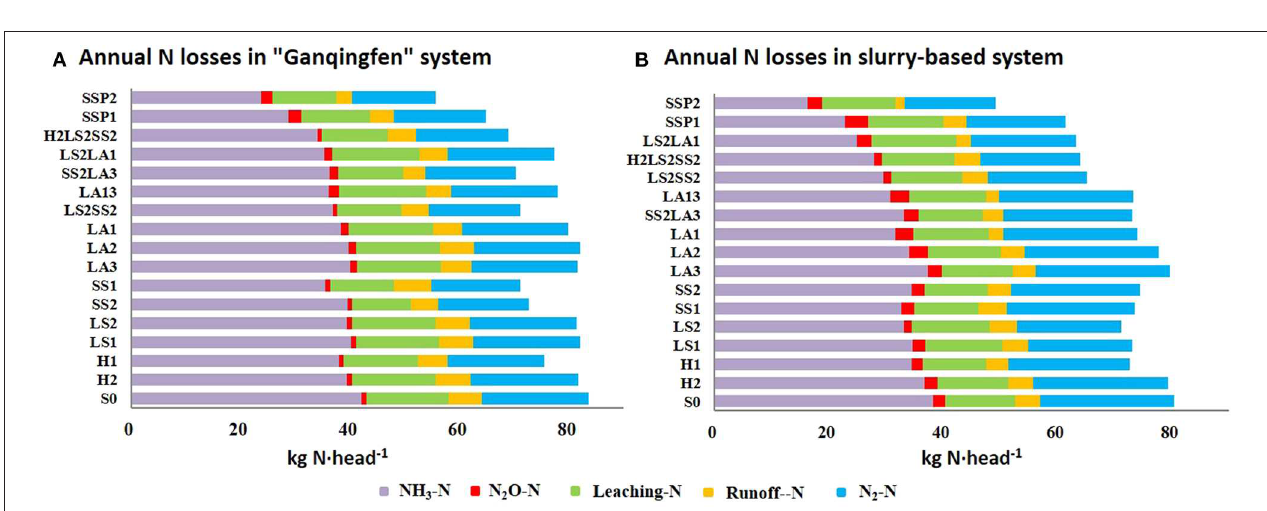
FIGURE 4 | Annual N losses per head cattle in manure management system under different scenarios. (A) N losses in “Ganqingfen” system. (B) N losses in slurry-based system.